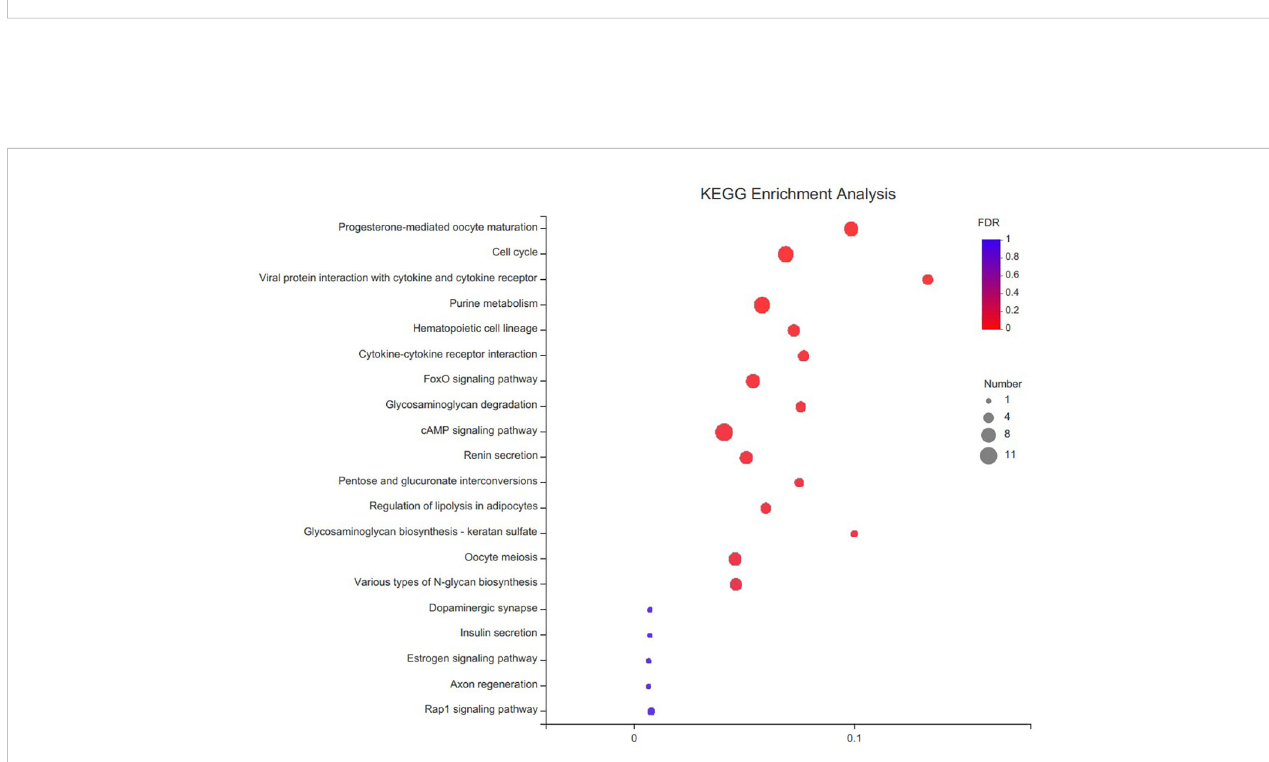
FIGURE 5 KEGG enrichment analyses of differentially expressed genes (DEGs) in C. sinensis transcriptome. The vertical coordinate is the name of the KEGG metabolic pathway and the horizontal coordinate is the number of transcript/unigene annotated to the pathway.